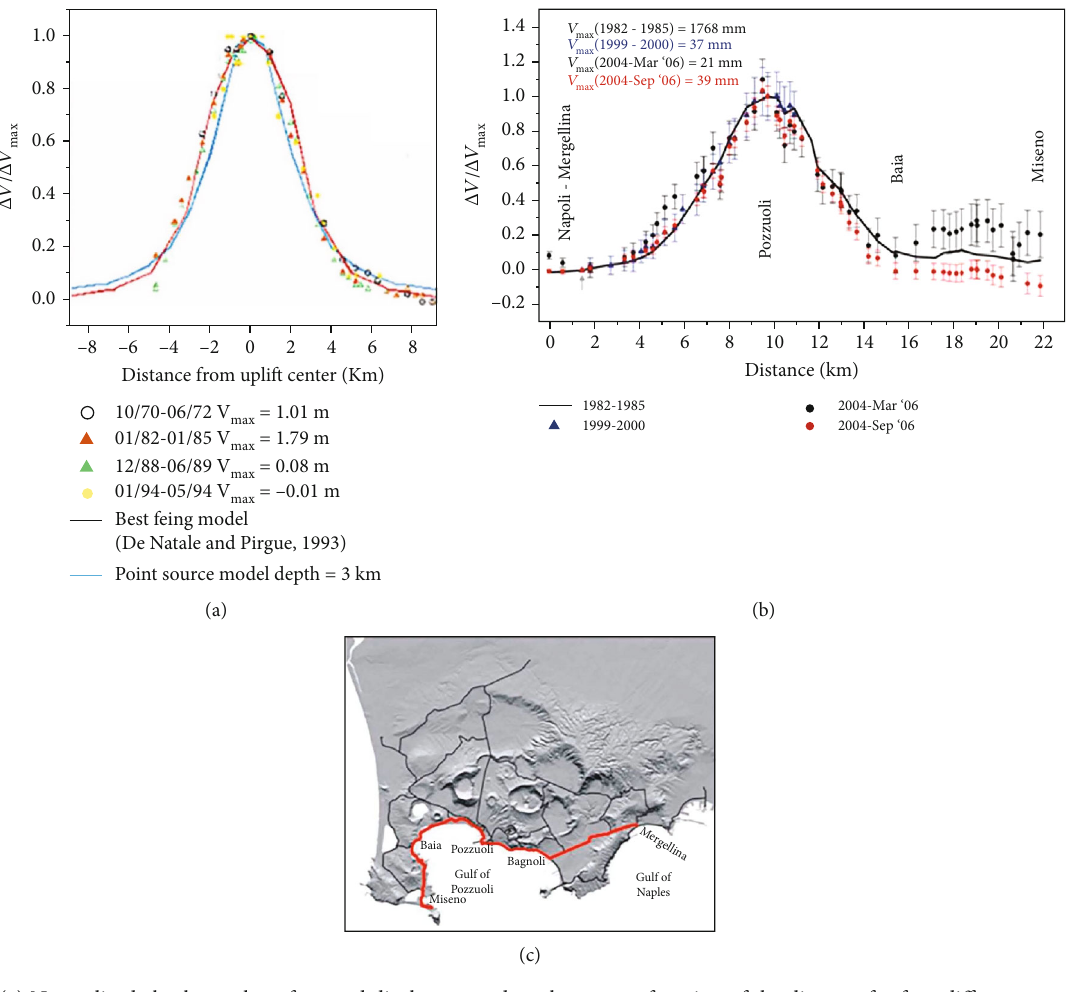
Figure 7: (a) Normalized absolute value of ground displacement data shown as a function of the distance for four di ff erent unrest periods (De Natale and Pingue [7]). (b) Normalized absolute value of ground deformation measured by precision levelings (along the red line in (c)) from 1982 to 2006. (c) The main leveling route from Naples to